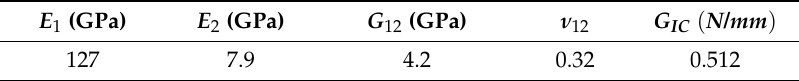
Table 2. Material properties of CFRP composite DCB specimen.